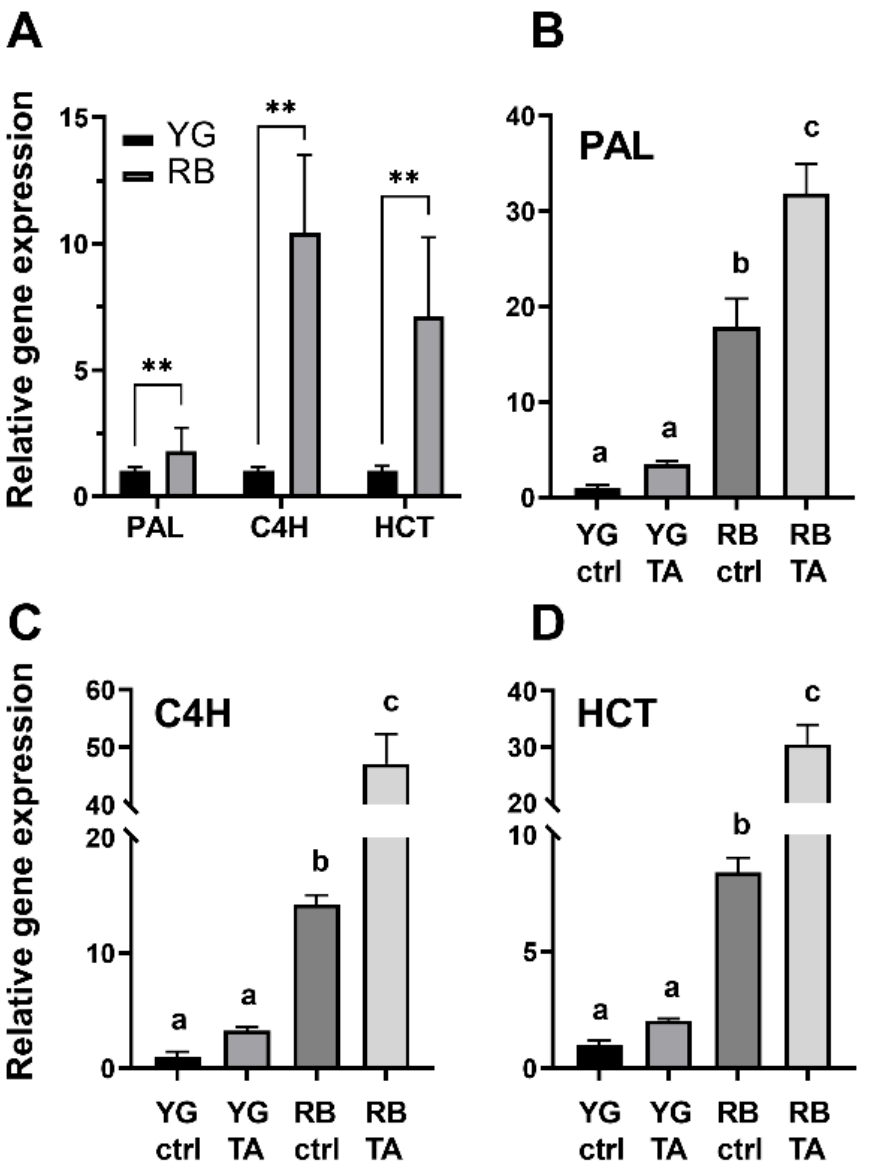
Figure 5. TA induces the expression of genes involved in phenylpropanoid biosynthesis in RB and YG tubers. ( A ) Relative gene expression of Phenylalanine ammonia-lyase (PAL), Cinnamate 4-hydroxylase (C4H) and Hydroxycinnamoyl-Coenzyme A shikimate:quinate hydroxycinnamoyl-transferase (HCT) in control (ctrl) mature potato tubers. Values represent means ± SEM (n = 4). The asterisks (**) indicate means statistically different according to two-way ANOVA followed by Fisher’s LSD ( p ≤ 0.001). Relative gene expression of ( B ) PAL, ( C ) C4H, and ( D ) HCT 48 h after treatment with MeOH (ctrl) and TA (10 µM). qPCR data is presented as the mean of 4 biological replicates ± SEM; different letters (a, b, c) indicate significantly different means according to two-way ANOVA followed by Fisher’s LSD ( p ≤ 0.05).